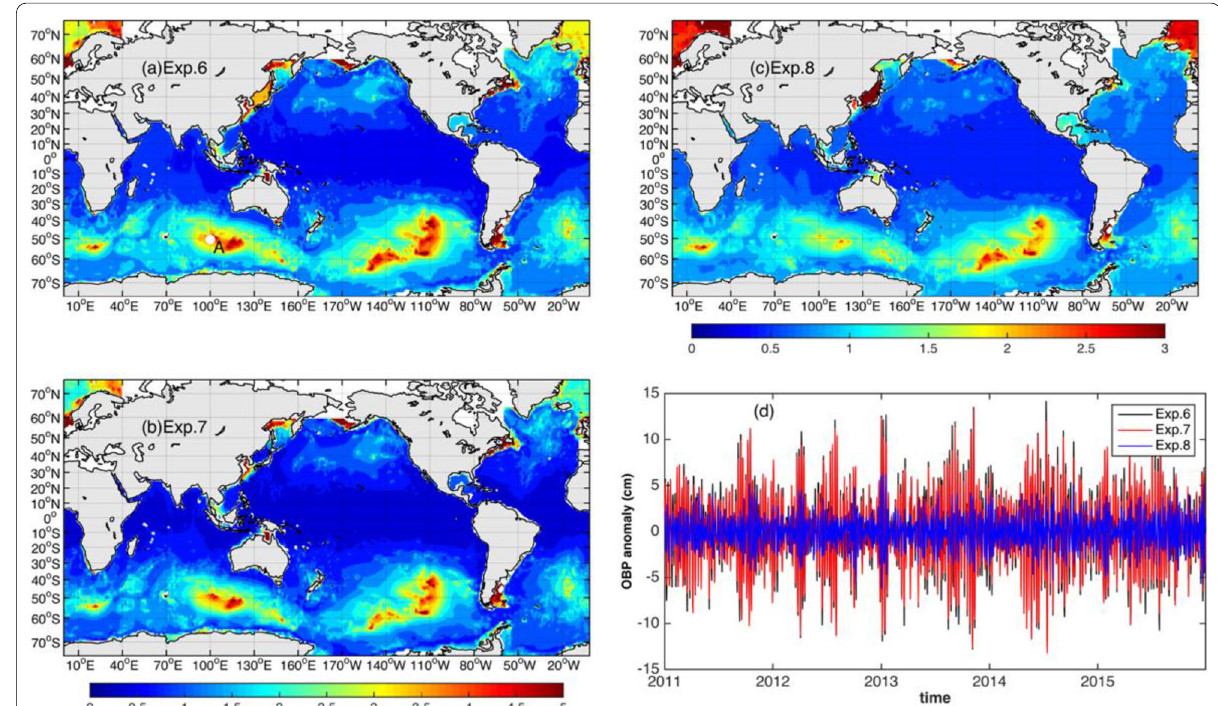
Fig. 8 a Standard deviation (STD, cm) of high-pass-filtered ocean bottom pressure anomalies with period shorter than 10 days during 2003–2018 for Exp. 6, b same as a but for Exp.7, c same as a but for Exp.8, d ocean bottom pressure time series at point A during 2011–2015 for Exp. 6 (black curve), Exp. 7 (red curve) and Exp. 8 (blue curve). Station A in a is located at (100 °E, 50